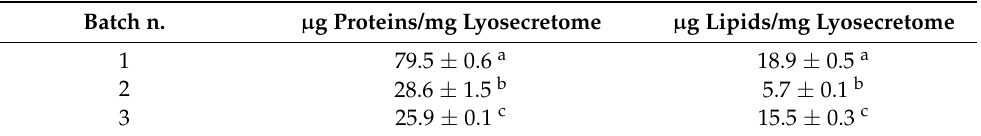
Table 8. Total protein and lipid content in Lyosecretome batches; mean values ± standard deviation, n = 3. Different letters (a, b and c) indicate a significant difference between groups of the same column ( p < 0.0001). Batch n. µ g Proteins/mg Lyosecretome